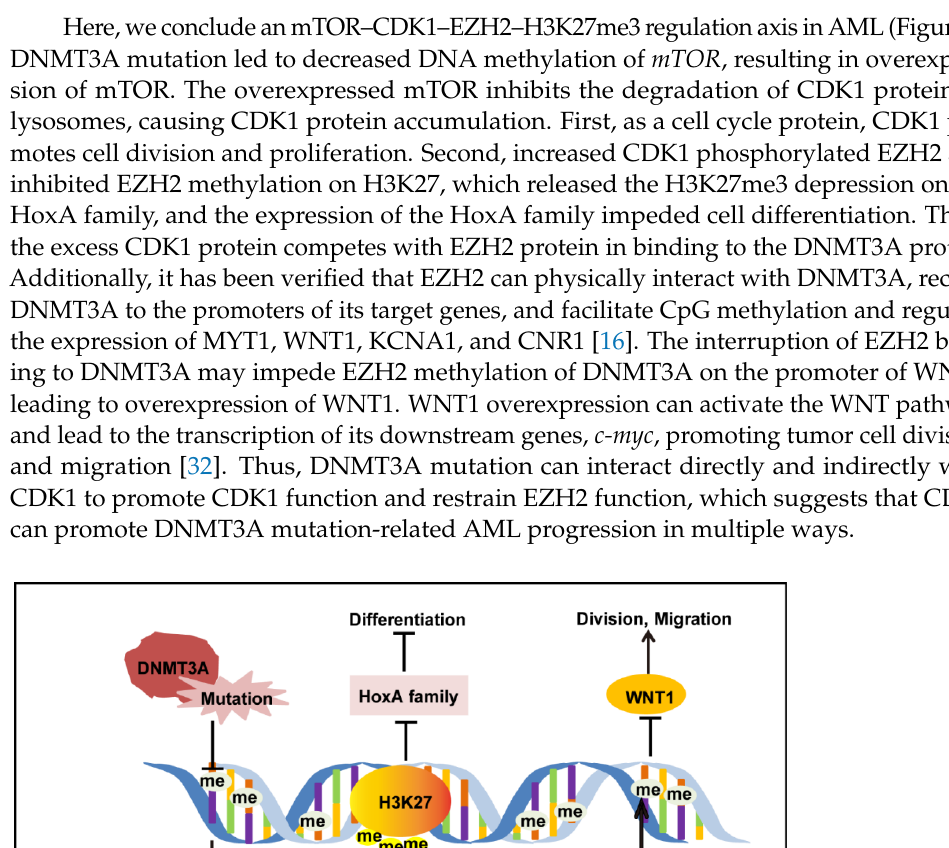
revealed no obvious change in morphology. Thus, CDK1 inhibitors can arrest cell cycle and induce apoptosis in AML cells with DNMT3A mutation.